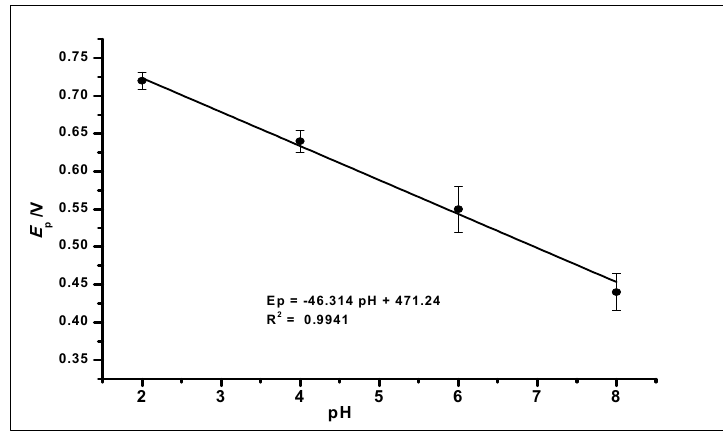
Figure 9. The plot of the peak potential ( E p ) against the di ff erent pH values of the bu ff er solution, showing a linear relationship.